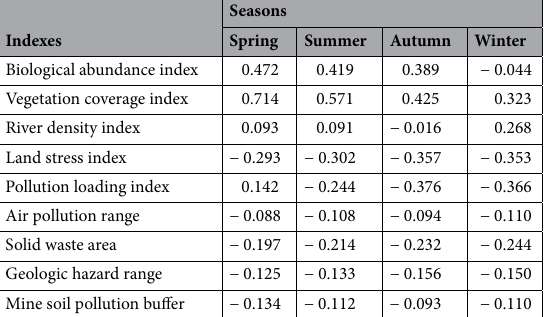
Table 7. Pearson correlation coefficient values between the evaluation results and evaluation